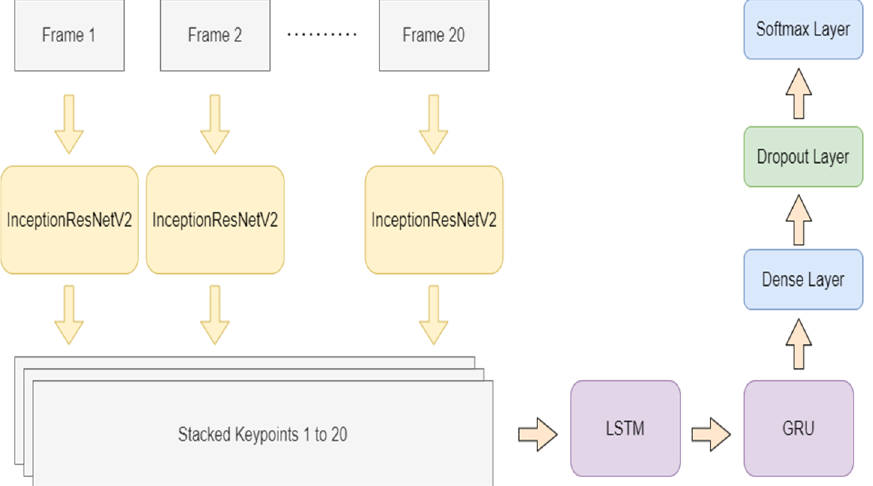
Figure 1. Multi-layer system architecture using InceptionResNetV2, LSTM, and GRU for sign recognition in video frames.